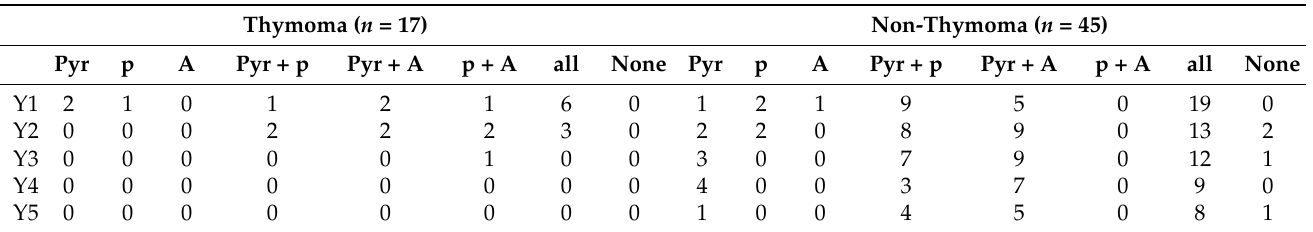
Table 2. Number of the patients who continued to have MG drugs after the thymectomies in each follow-up year between ThMG and non-ThMG